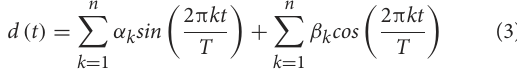
Three common procedures for testing unit root tests, KPSS, ADF, and PP, were implemented to test the variables for stationarity. The null hypothesis states that a time series has a unit root. If the null hypothesis is rejected, the time series is stationary. If not rejected, it is not stationary. In Table 2, the results indicate that CO 2 emissions in the United States are integrated at I (0) order while all other variables for the three countries are integrated at I (1) order. Thus, all of the variables are stationary at level or at the first difference. McNown et al. (50) suggest that the bootstrap ARDL model is appropriate for testing the co-integration relation between variables if no variables are integrated at I (2) order or above.